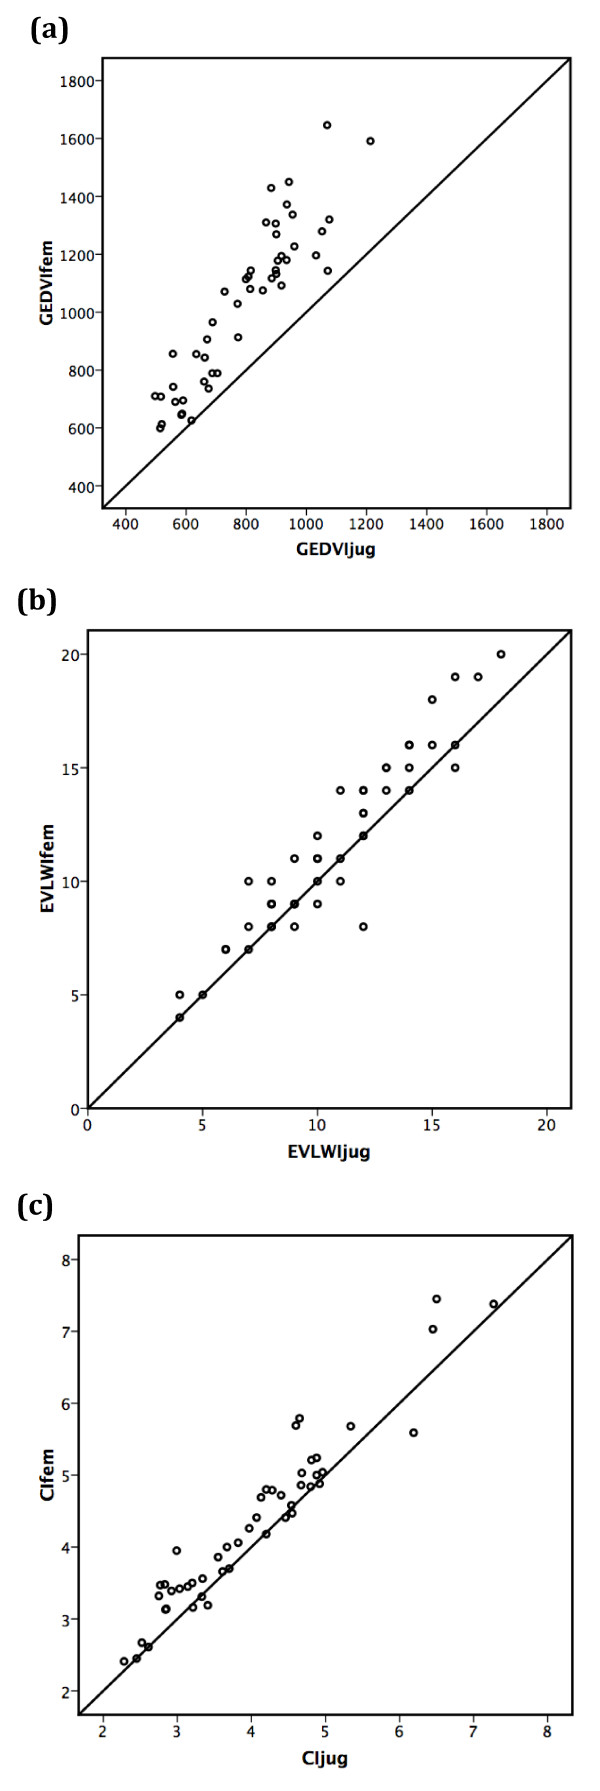
Correlation of femoral and jugular transpulmonary thermodilution variables. Scatter plot showing the correlation of femoral and jugular global end-diastolic volume index (rm = 0.88; P < 0.001) (a), femoral and jugular extra-vascular lung water index (rm = 0.93; P < 0.001) (b), and femoral and jugular cardiac index (rm = 0.95; P < 0.001) (c). GEDVIjug, jugular global end-diastolic volume index (mL/m2); GEDVIfem, femoral global end-diastolic volume index (mL/m2); EVLWIjug, jugular extra-vascular lung water index (mL/kg); EVLWIfem, femoral extra-vascular lung water index (mL/kg); CIjug, jugular cardiac index (L/min/m2); CIfem, femoral cardiac index (L/min/m2).